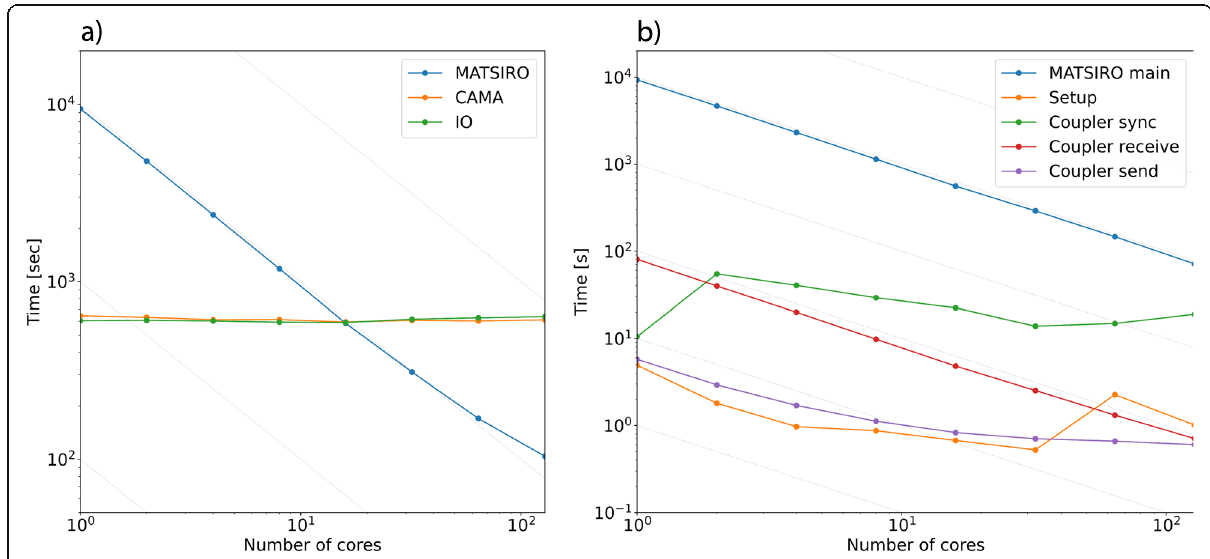
Fig. 8 a Computational speed and scalability. Relationship between number of cores for each component ( x axis) and computational time ( y axis). We only changed the number of cores from 1 to 128 for one component and fixed the number of cores for the other two components to 16. b Computational speed of MATSIRO ’ s component in relation to the number of